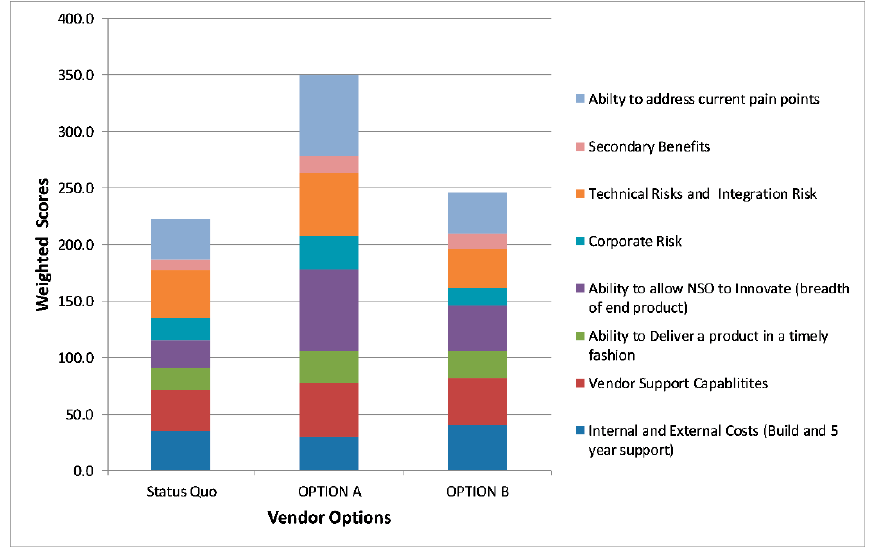
Figure 5. NSO’s Decision Matrix Analysis tool that was used to make final vendor choices.